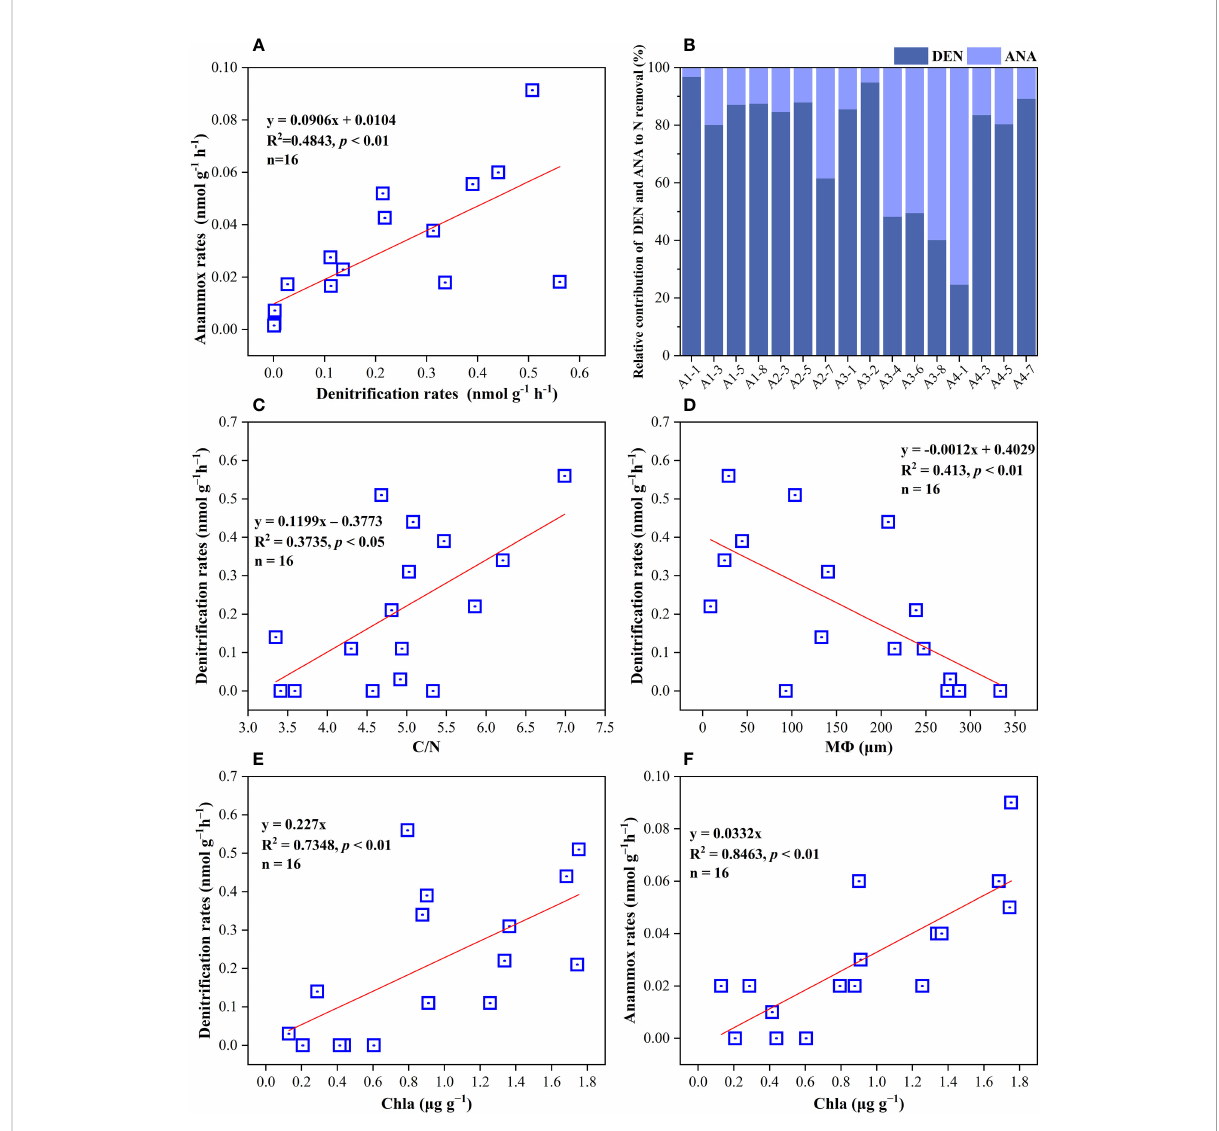
FIGURE 5 (A) Correlations analysis of anammox rates with denitri fi cation rates in surface sediments. (B) The percentage of denitri fi cation and anammox to NO x − removal in all sampling sites. (C – F) their regulating factors in sediments of the Yangtze Estuary and adjacent